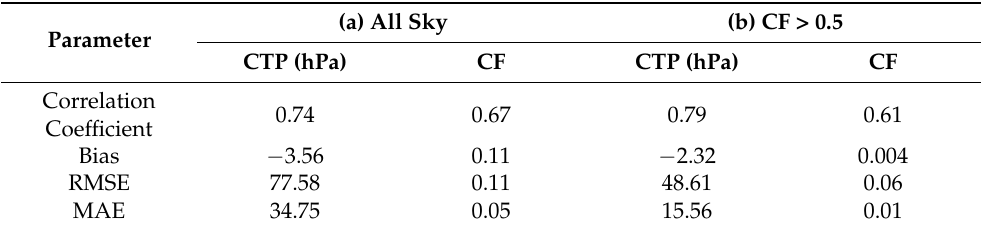
Table 3. Statistical results of CTP and CF for coverage of cloud pixels in ( a ) all sky and ( b ) significant CF